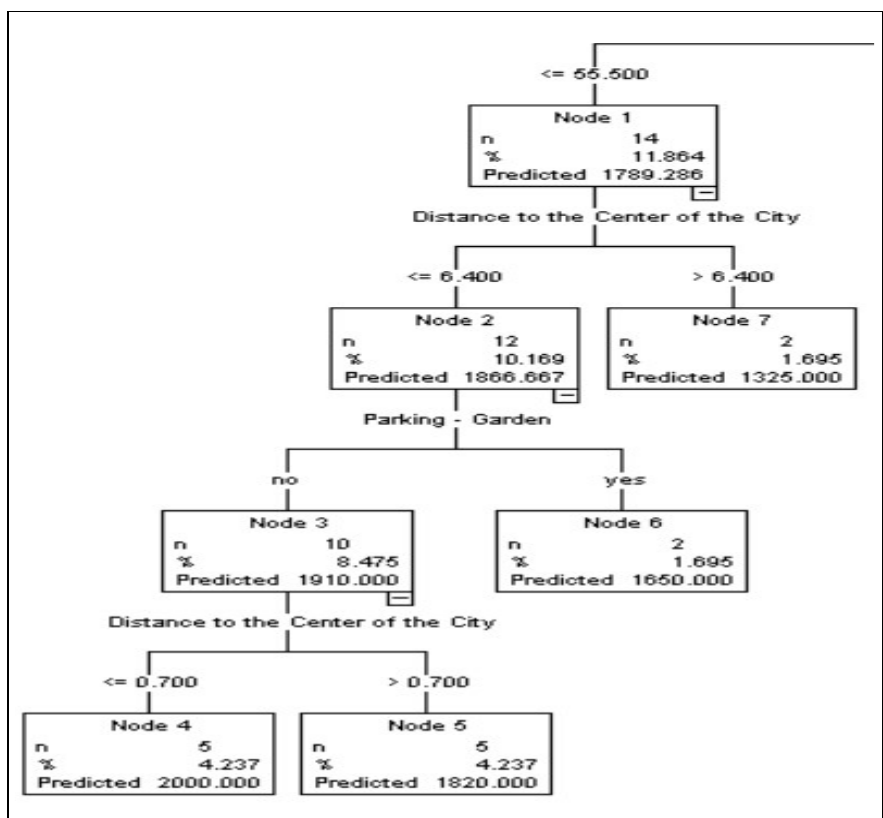
Fig. 8. Decision tree node 1 and the estimated real estate unit value (developed by the